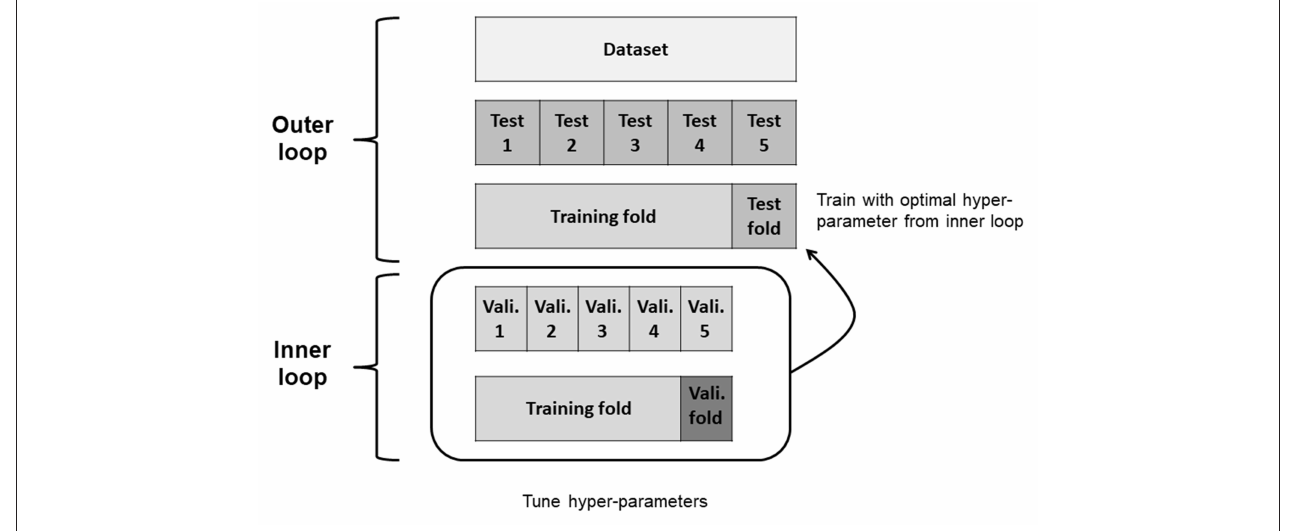
FIGURE 1 | Flow chart of the 5-fold nested cross-validation. Vali., validation.